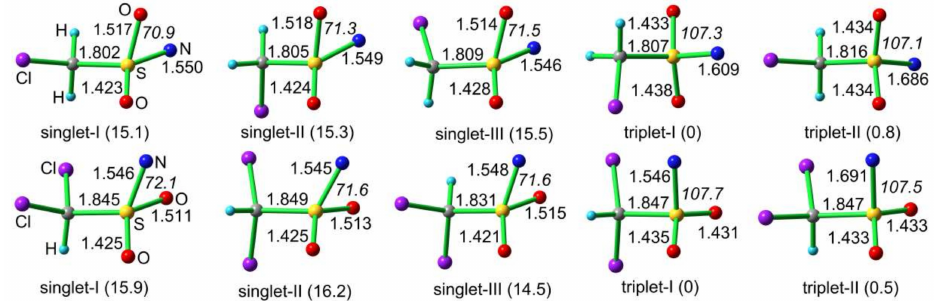
Figure 7. Calculated molecular structures and relative energies (in parentheses, kcal mol − 1 ) of CH 2 ClS(O) 2 N and CHCl 2 S(O) 2 N at the B3LYP/6-311++G(3df,3pd) level. Selected bond lengths in Å and angles in ◦ (in italics) are